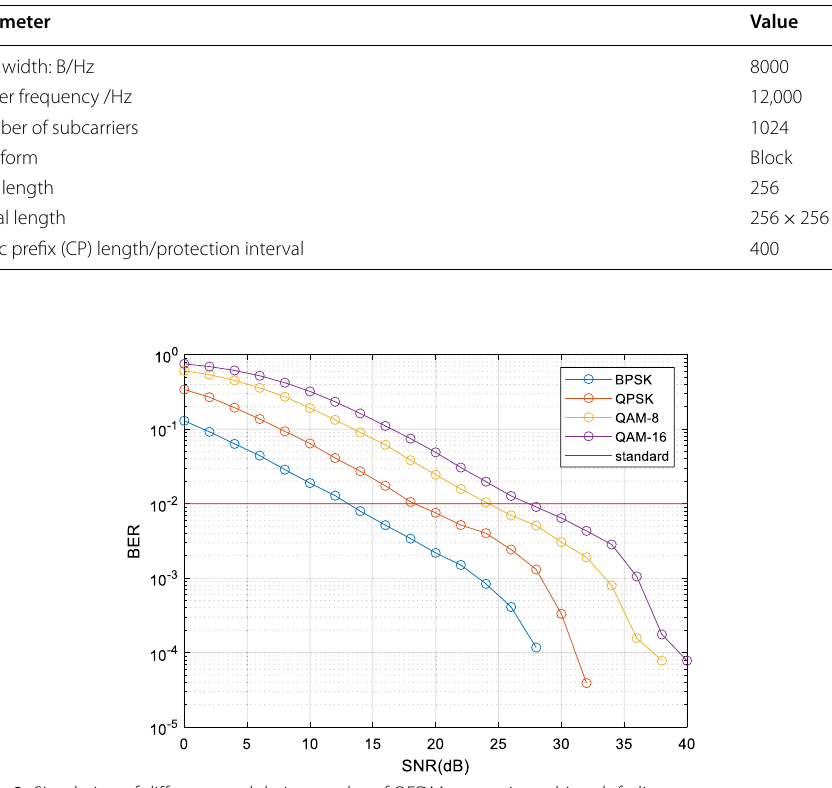
Table 2 M odulation scheme in UNDERWATER acoustic